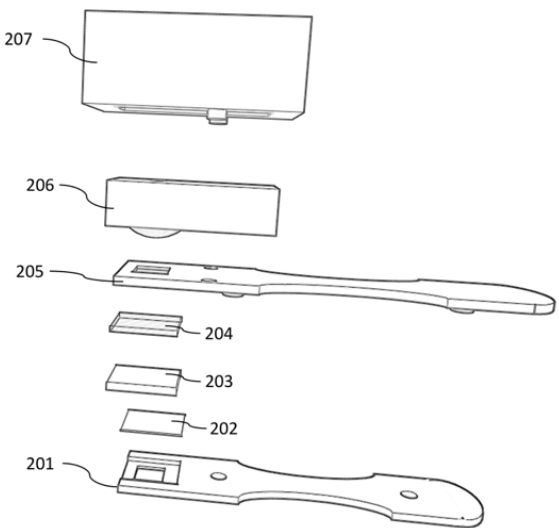
Figure 1. Schematic diagram of the electronic nose. 201 and 205—3-D printed housing; 202—plastic film; 203—gauze pad; 204—PTFE membrane; 206—MQ-135 sensor; and 207—3-D printed housing for electronic nose.